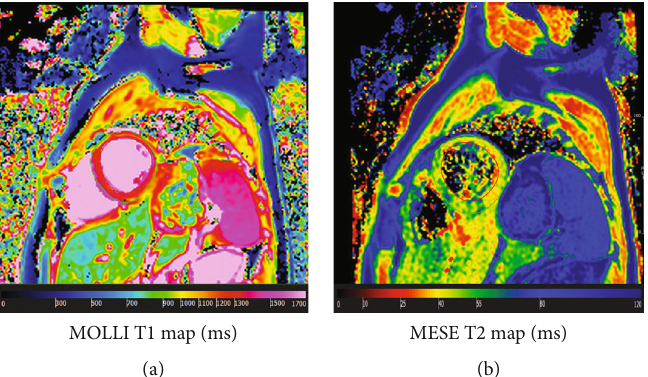
Figure 8: T1 and T2 mappings. Modi fi ed Look-Locker Inversion recovery (MOLLI) T1 map (a) and multiecho fast spin echo (MEFSE) T2 map (b) acquired in a healthy volunteer. Myocardial T1 and T2 values lie within normal range as shown by the color